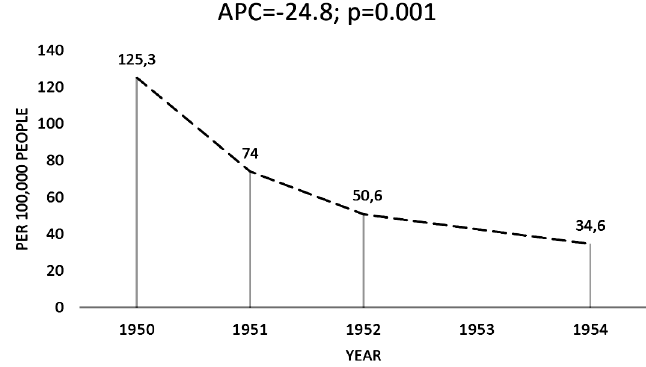
Figure 2. Syphilis incidence rates in the years 1950–1954 recorded, with the incidence rate of 125.3 persons per 100,000. In the pe- riod 1950–1954 (Figure 2), an almost 25% decrease in incidence per year was noted ( AP C = − 24 . 8 ; p < 0 . 001 ). The incidence rate fell to the level of 34.6 per 100,000 persons. Such a success made it seem that the problem of venereal diseases had been solved, which is why the Institute was closed down in 1957 and many campaigns aimed at prevention were withdrawn (Jabłońska,